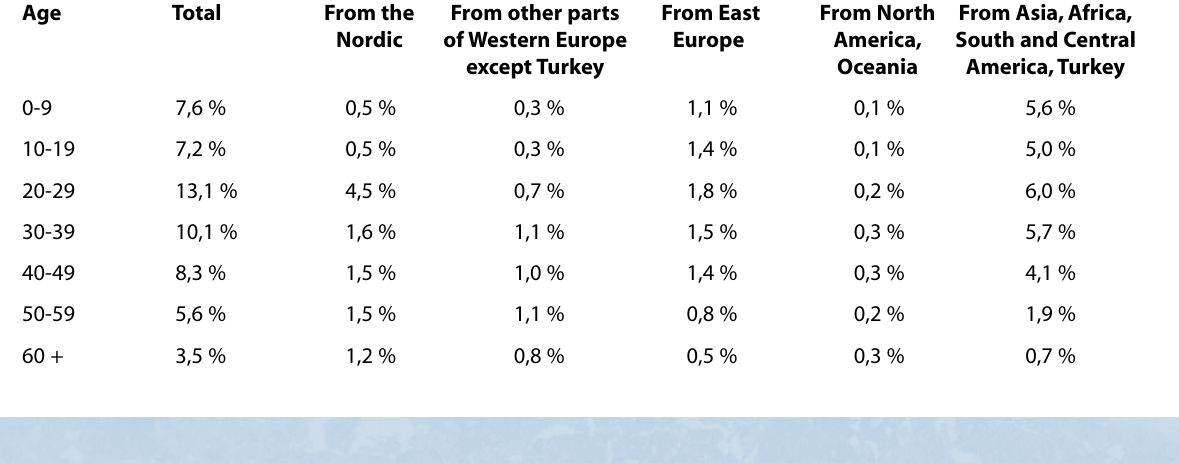
From the From other